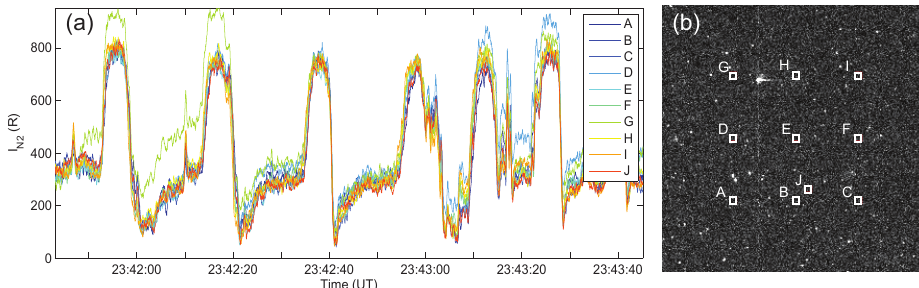
Figure 5. (a) N 2 emission brightness in 10 different locations across the ASK field of view. The locations where the brightness has been measured are shown in (b) . Very little variation in brightness is seen for the different measuring points, and the brightness dips at the beginning of the pulsation OFF period are equally distinguished in all locations.